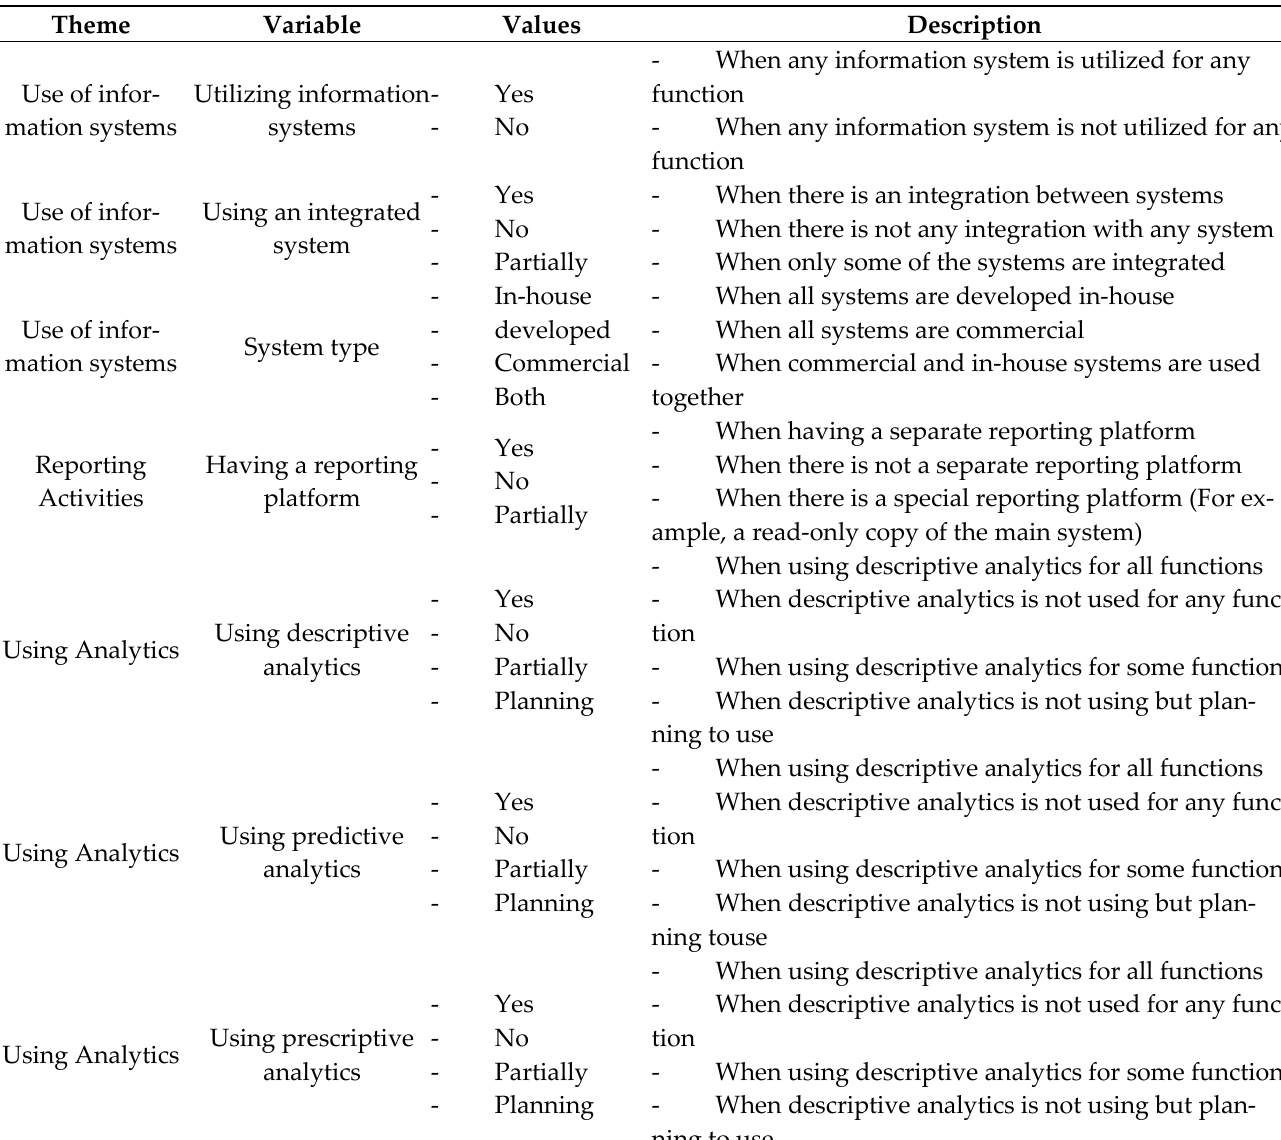
Table 2. Descriptive analysis